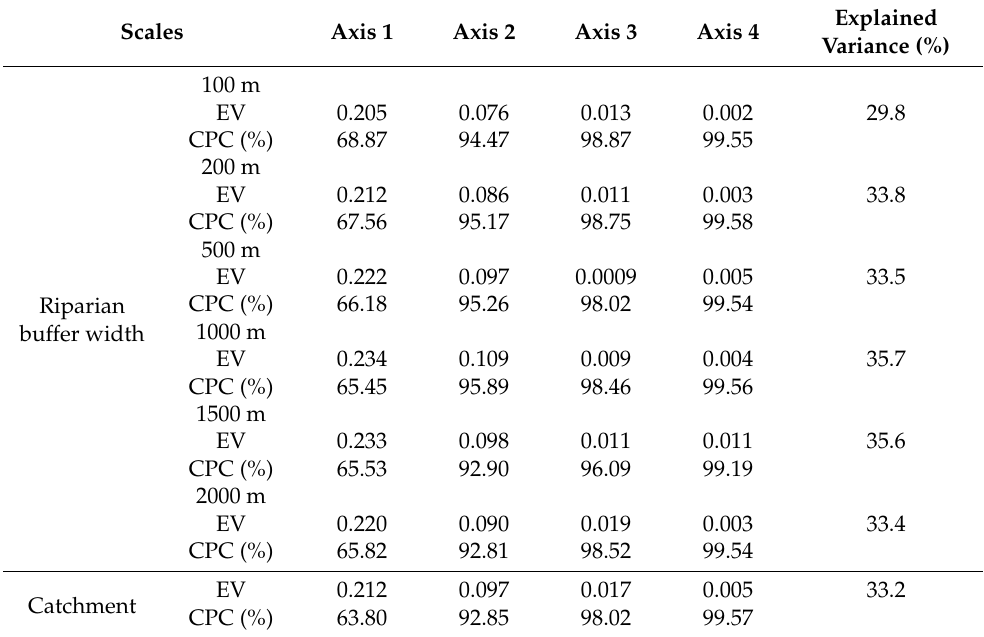
Table 3. RDA ranking axes and the total variance explanatory rate at each buffer width and catchment scale.